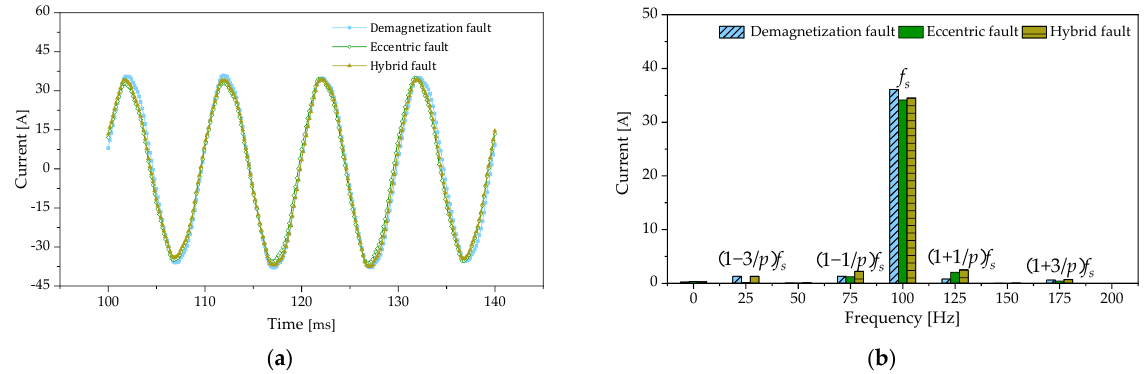
Figure 4. MBCS waveforms of motors with different faults ( a ) in the time domain and ( b ) in the frequency domain.